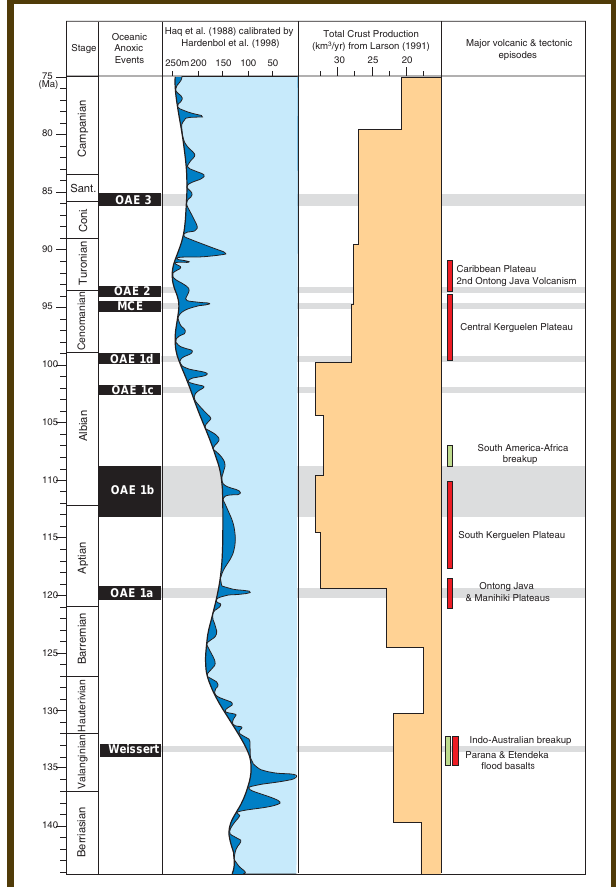
Figure 1. OAE horizons, sea level changes and production rate of the oceanic